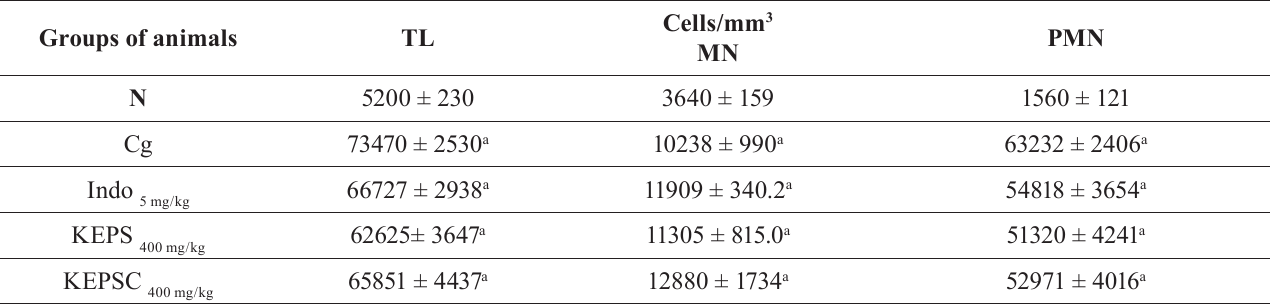
Pleurisy was induced by intrapleural carrageenan injection (Cg - 200 µg/cavity) in rats (n = 6 – 7) 1 h following oral administration of polysaccharides at 400 mg/kg or saline (Cg). Indomethacin (Indo; 5 mg/kg) was administered subcutaneously as an anti- inflammatory reference drug (positive control). N = normal animals that received no pleural injection of carrageenan; TL = total leukocytes; MN = mononuclear leukocytes; PMN = polymorphonuclear leukocytes. Each point represents the mean ± standard error of the mean of the number of leukocytes recruited into the pleural cavity 4 h following injection of carrageenan. a p < 0.05 compared with normal rats (ANOVA, Tukey’s